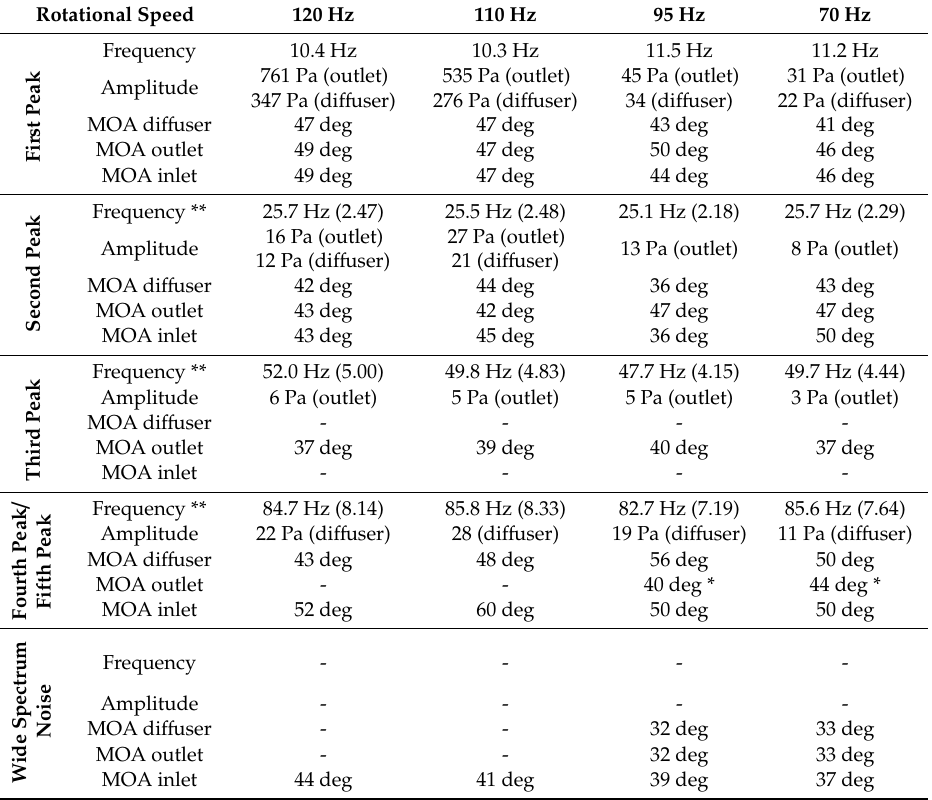
Table 3. Summary of main observations regarding the unstable flow structures appearing at di ff erent rotational speeds (MOA—The moment of